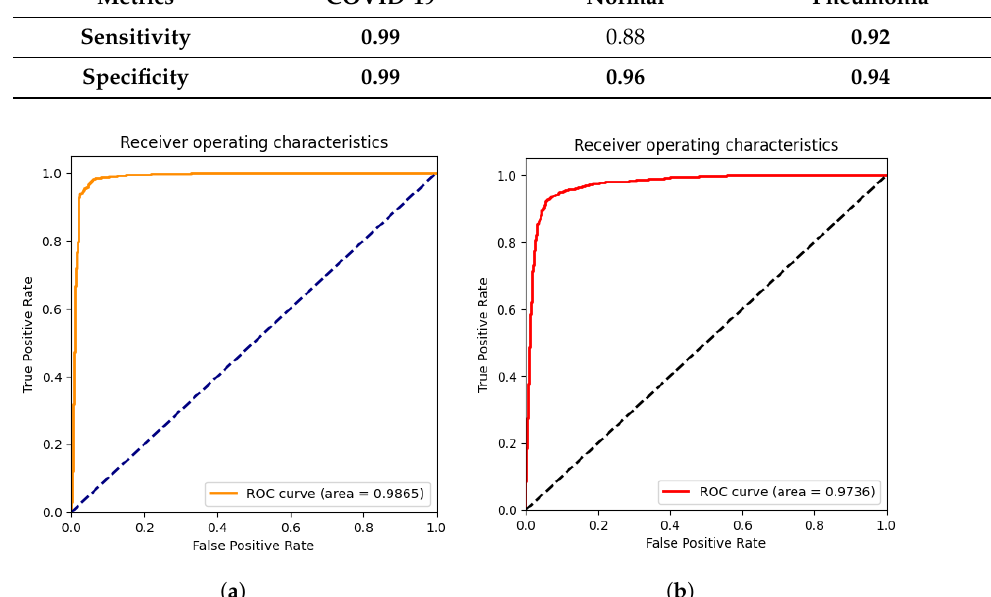
Figure 18. ROC curve of both models: ( a ) DeepCCXR-Bin (COVID-19 vs. normal); ( b ) DeepCCXR- Multi (COVID-19 vs. other pneumonia vs.